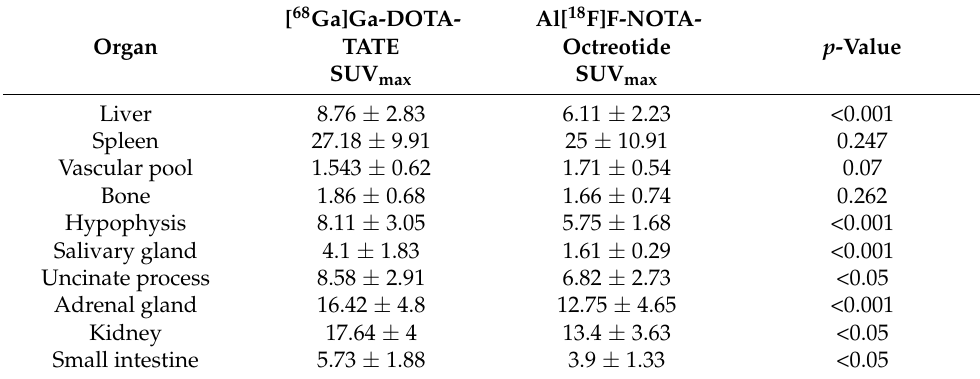
Table 2. [ 68 Ga]Ga-DOTA-TATE PET and Al[ 18 F]F-NOTA-Octreotide PET SUV max values.